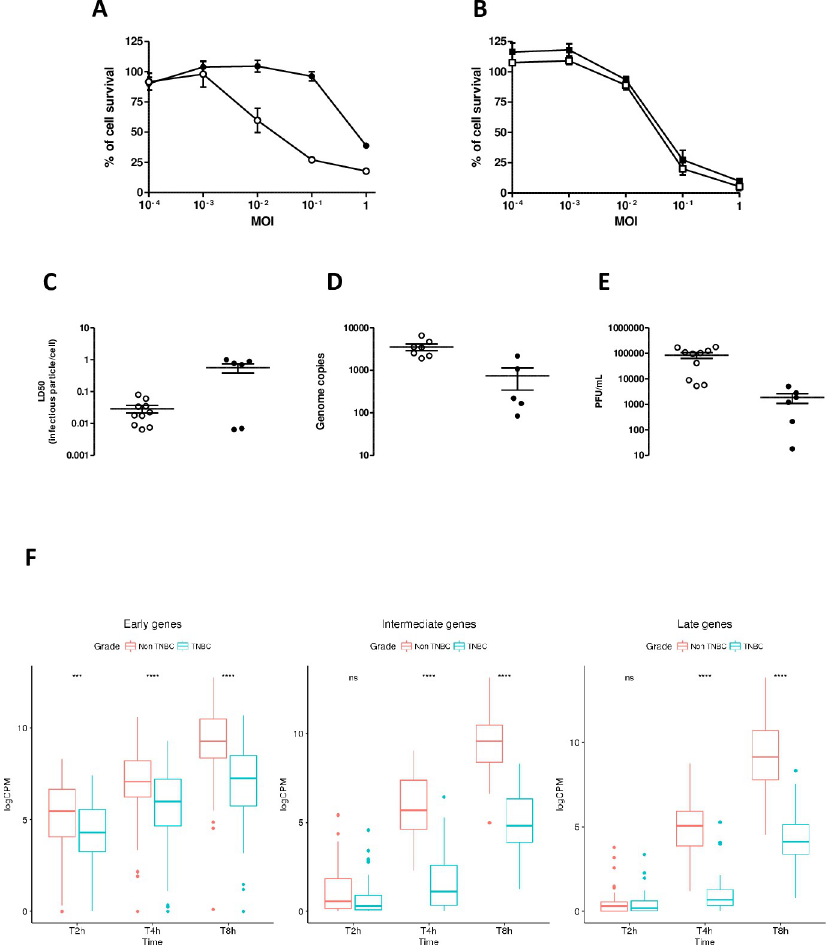
Fig 1. Comparison of the efficacy of VV on non-TNBC or TNBC of different origins. A. Primary canine cells (non TNBC: white circles; TNBC black circles) or B. human established cell lines (MCF7: white squares, as a non-TNBC established cell line; MDA-MB-231: black squares, as a TNBC established cell line) were infected at different MOIs with VV. Fours days later, the remaining cells were estimated using a MTT assay. The results are presented as a percentage of cell-survival in uninfected cells and are the mean +/- SEM of six different experimental points. The results presented are representative of two independent experiments. C. A similar experiment was performed on the cohort of non-TNBC and TNBC cells. For each primary line, two independent experiments involving each six experimental points were performed to calculate the LD50. Each point (white circles: non-TNBC, black circles: TNBC) represents the mean of the two experiments). The bars represent the mean LD50 +/- SE obtained on ten independent non-TNBC and six independent TNBC cultures. LD50 on the Y-axis is expressed as the ratio of infectious viral particles to mammalian cells capable of killing 50% of the cell population. D. Twenty-four hours after VV infection (MOI = 0.1), non-TNBC (white circles) or TNBC (black circles) cells were collected, and DNA was isolated and subjected to quantitative PCR to titer the number of viral genomes per well. Each circle represents the mean of two independent experiments performed in triplicate. The mean and SEM of the VV genome copies produced in non- TNBC and TNBC primary cells are presented ( E ). Three days after VV infection (MOI = 0.1), non-TNBC (white circles) or TNBC (black circles) cells were collected, homogenized and the number of infectious particles generated in the culture dishes were titrated. Each circle represents the mean of two independent experiments, each performed in 6 experimental points. The means and SEMs of VV produced in non-TNBC and TNBC primary cells are presented. Details of the samples used to obtain these data (Fig 1A to 1E) are listed in S1 Table. F. TNBC (blue) or non-TNBC (red) carcinoma cells were infected at a MOI of 5. At different times post-infection (2, 4, 8 hours), the cells were collected and processed for RNA sequencing. The data represent the levels of early (left panel), intermediate (middle panel) or late (right panel) viral gene expression. CPM on the Y-axis stands for “Counts Per Million”. CPM is the count of sequenced fragments mapping to each relevant gene scaled by the total number of reads times one million. Details of the samples used to obtain these data are listed in S1